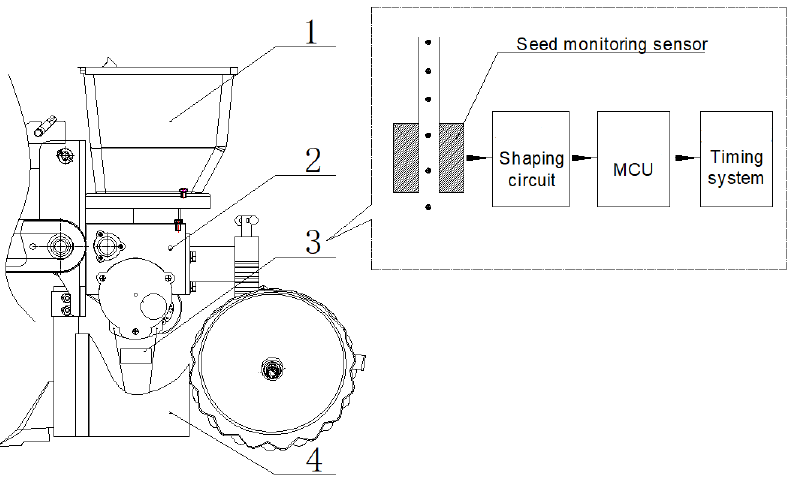
Figure 4. Schematic diagram of monitoring sensor position. 1. Seed box; 2. spoon-type seed metering device; 3. monitoring sensor; 4. ditching device side